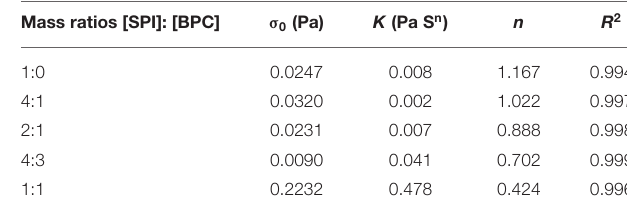
TABLE 2 | Rheological parameters of the emulsions stabilized by SPI/BPC complex using Herschel–Bulkley model. Mass ratios [SPI]: [BPC]